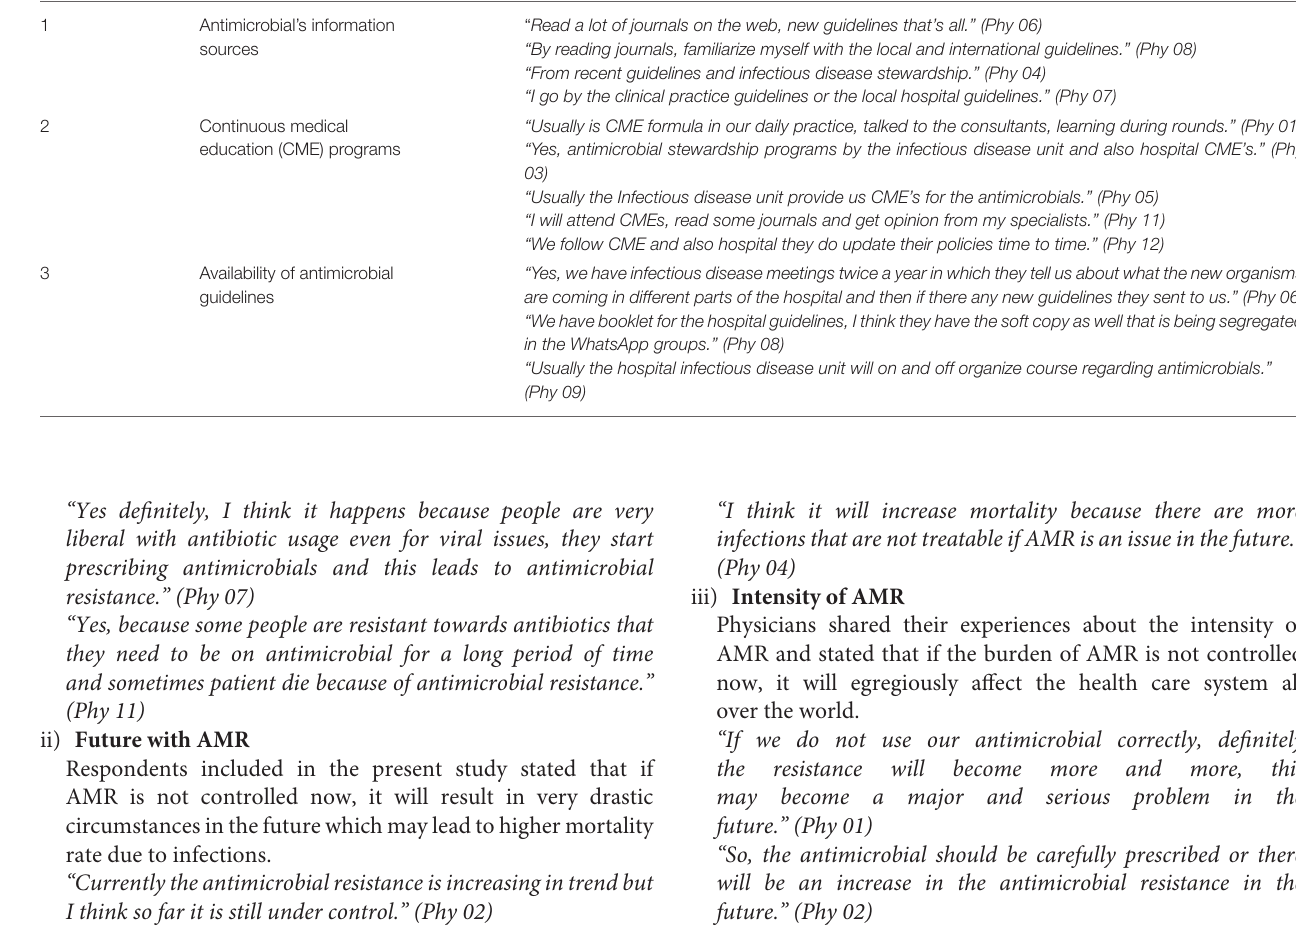
TABLE 2 | Physician’s antimicrobial knowledge. Sr.